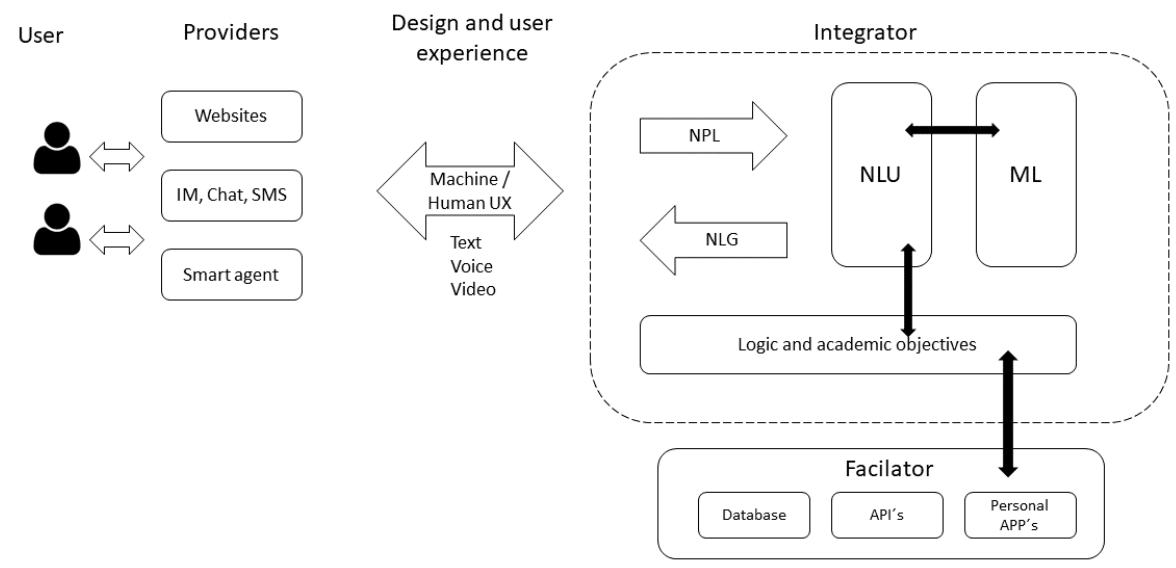
Figure 1. Architecture of a Chatbot with the integration of an artificial intelligence tool [17].